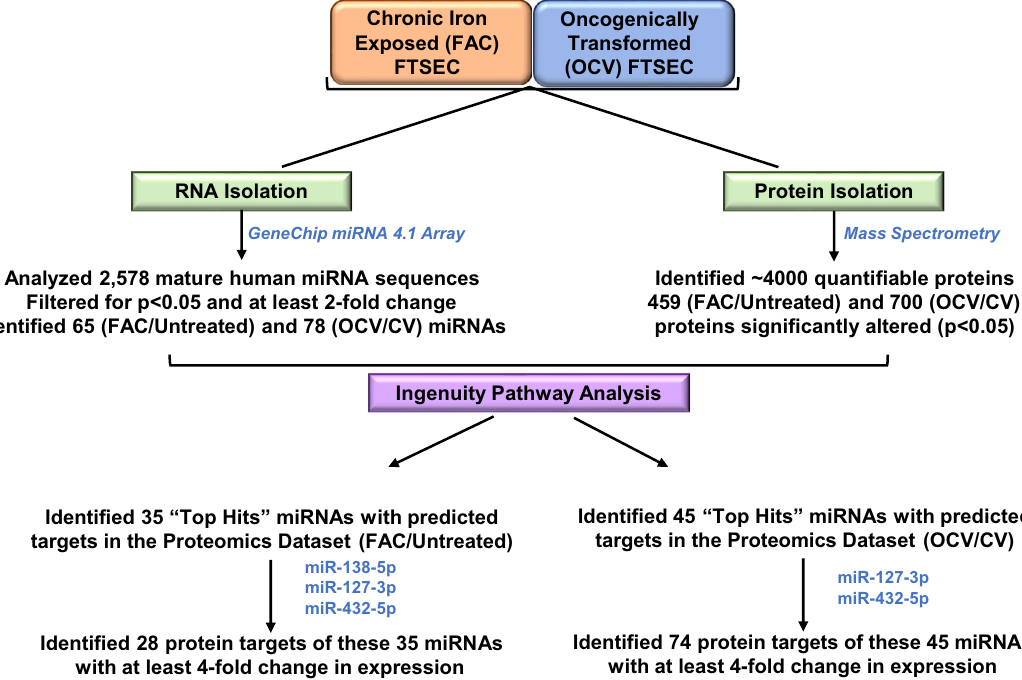
Figure 1. Schematic representation of the proteomics and microarray experimental strategy and analyses in FTSECs. Global proteomics analyses via mass spectrometry and miRNA analysis via Gene Chip miRNA 4.1 array were performed using chronic iron treated FT194 cells ( p = 30 at day 104 of FAC treatment) and transformed FT194 cells ( p = RV + 11) (with their corresponding control cells). This was followed by implementation of IPA to identify “top hits” of altered miRNA associated with protein